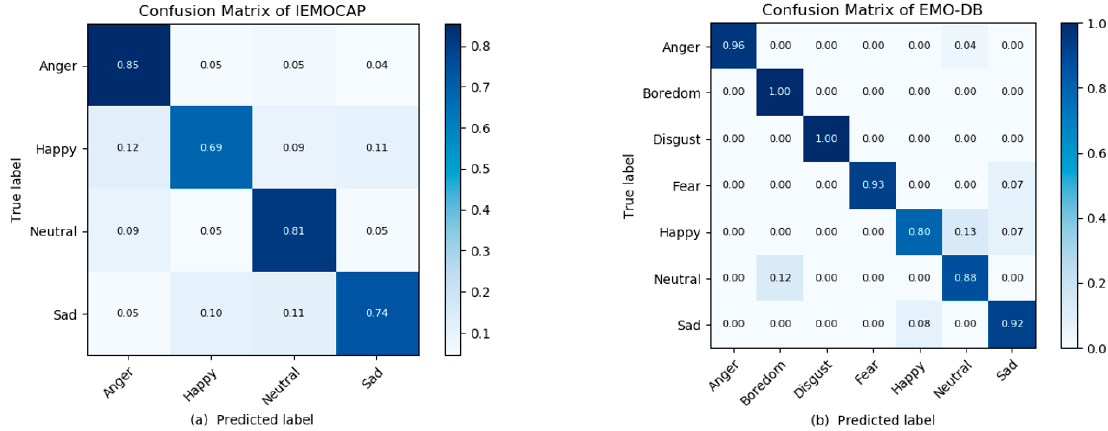
Figure 5. Confusion matrixes of the IEMOCAP and the EMO-DB datasets. ( a ) The IEMOCAP confusion matrix; ( b ) the EMO-DB confusion matrix. The x-axes show the predicted labels, and the y-axes show the actual labels.